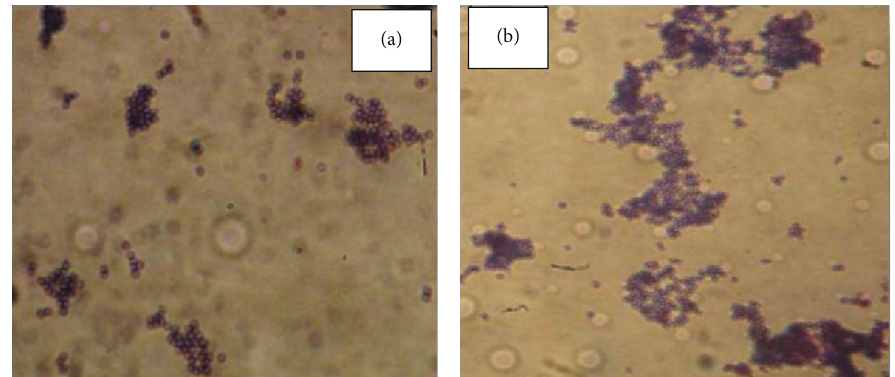
Figure 2: Morphology determination by means of Gram staining examined under light microscope (1000x) of S. aureus variants: (a) wild type; (b) resistant strain.